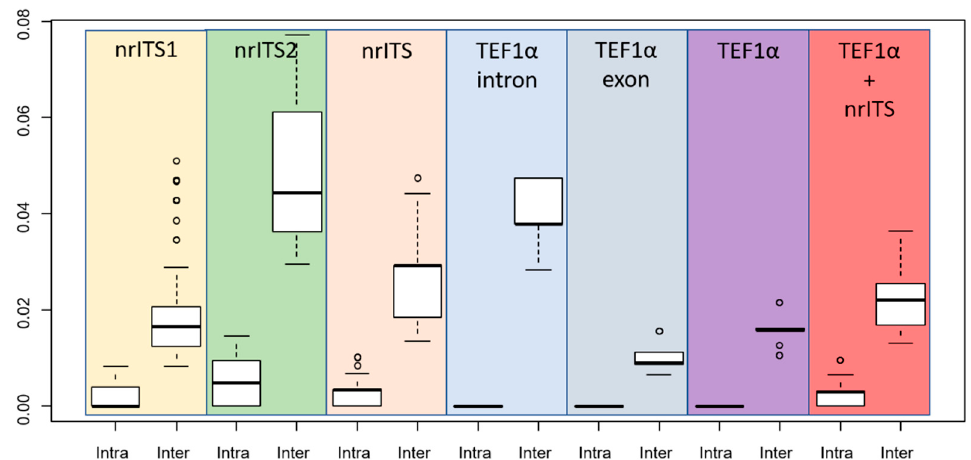
Figure 1. Best tree from the ML analysis of the nrITS + TEF1- α dataset. Bootstrap values ≥ 70% and posterior probabilities ≥ 0.90 are indicated on or below the branches. The root length has been reduced to facilitate graphical representation.